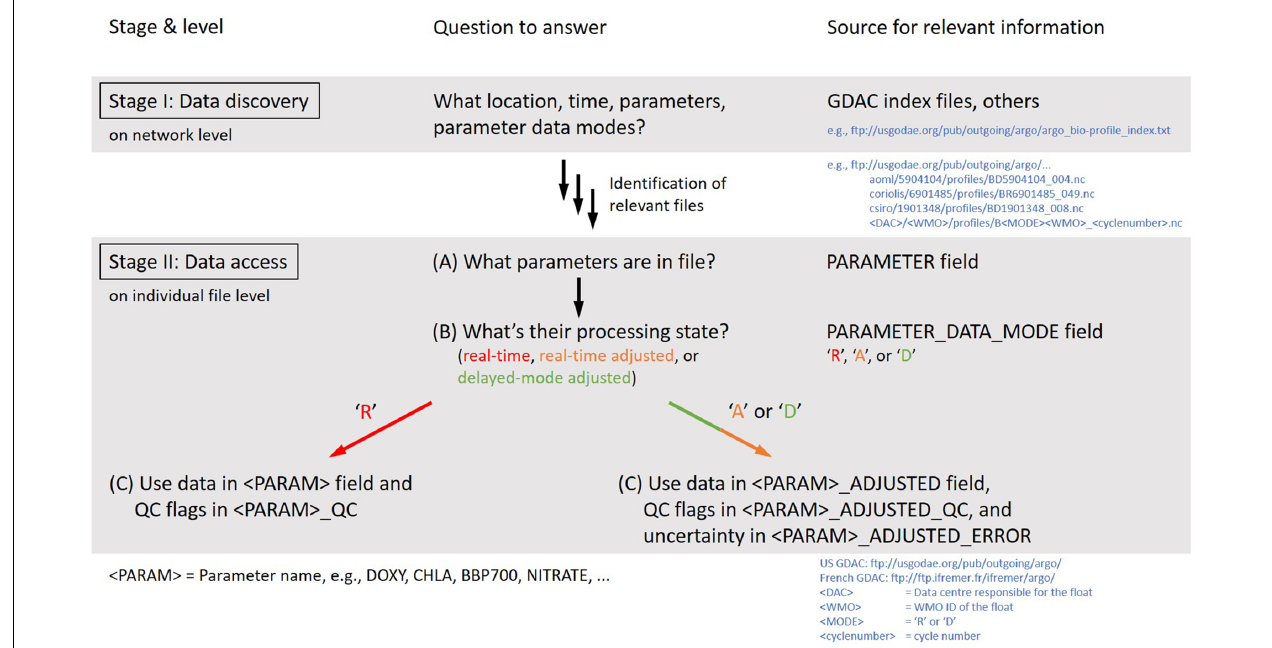
FIGURE 7 | Workflow how to discover (stage I) and access BGC-Argo data (stage II)